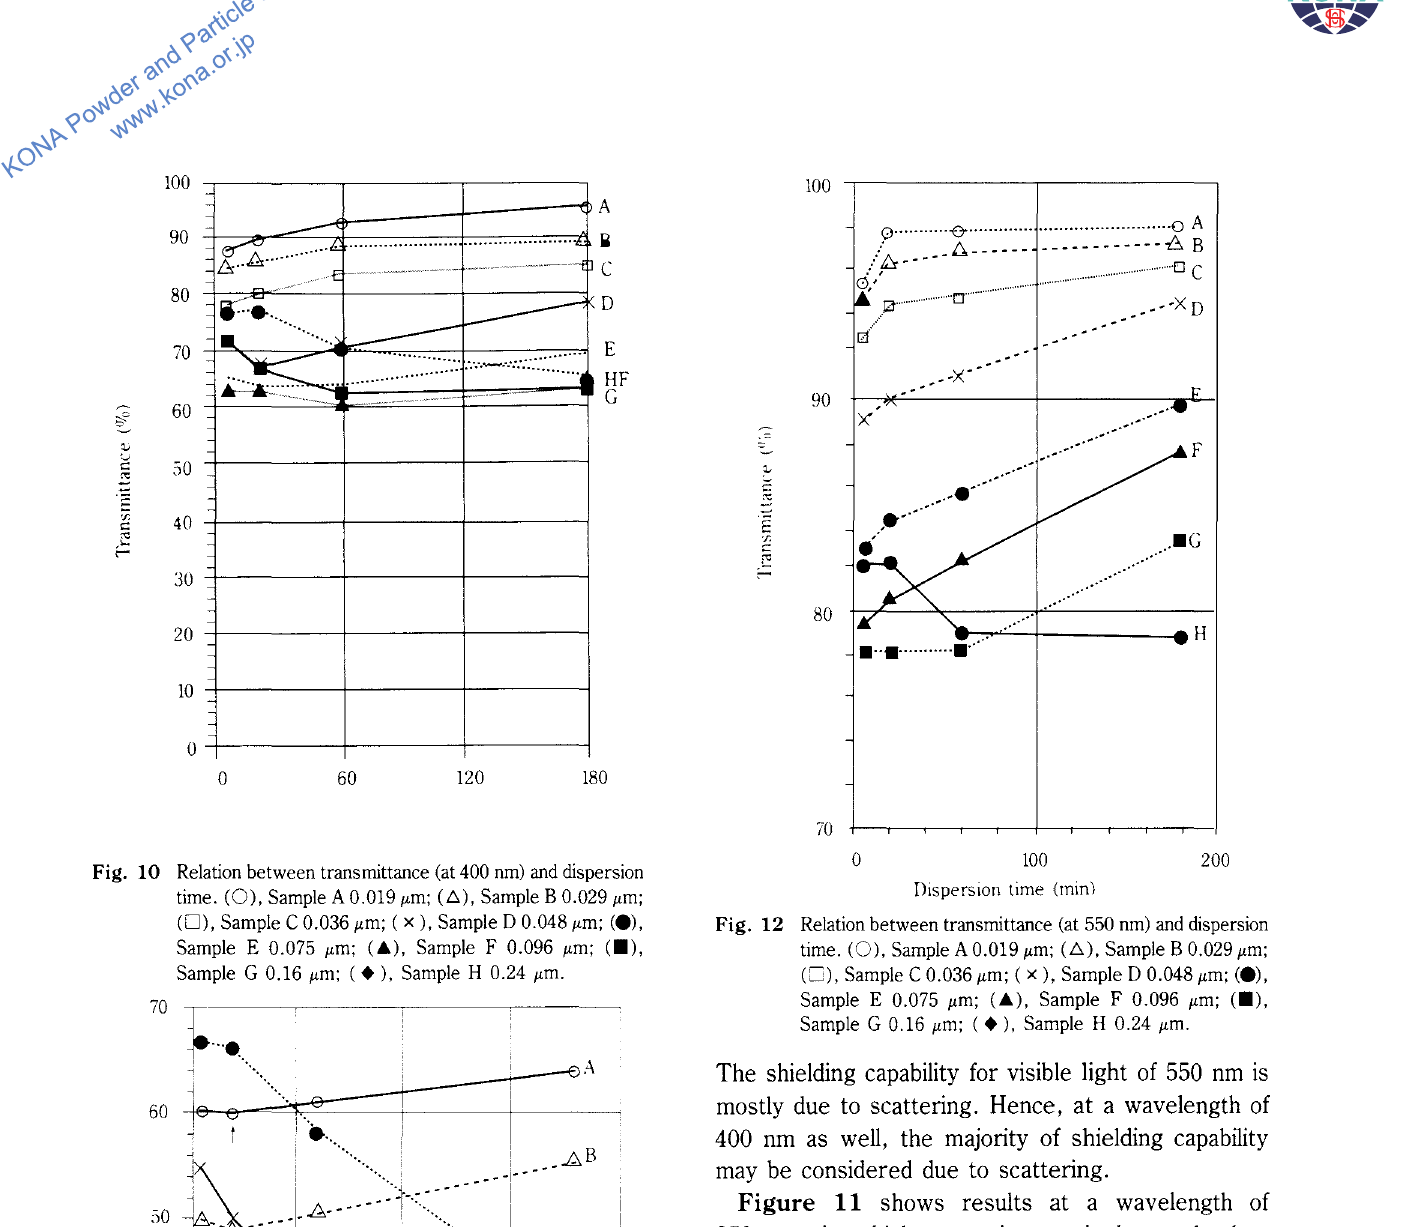
Fig. 10 Relation between transmittance (at 400 nm) and dispersion time. (0), Sample A 0.019/lm; (6), Sample B 0.029/lm; (0), Sample C 0.036/lm; ( x ), SampleD 0.048/lm; (e), Sample E 0.075 I'm; (A), Sample F 0.096 I'm; (•). Sample G 0.16 I'm; ( + ), Sample H 0.24 flill.